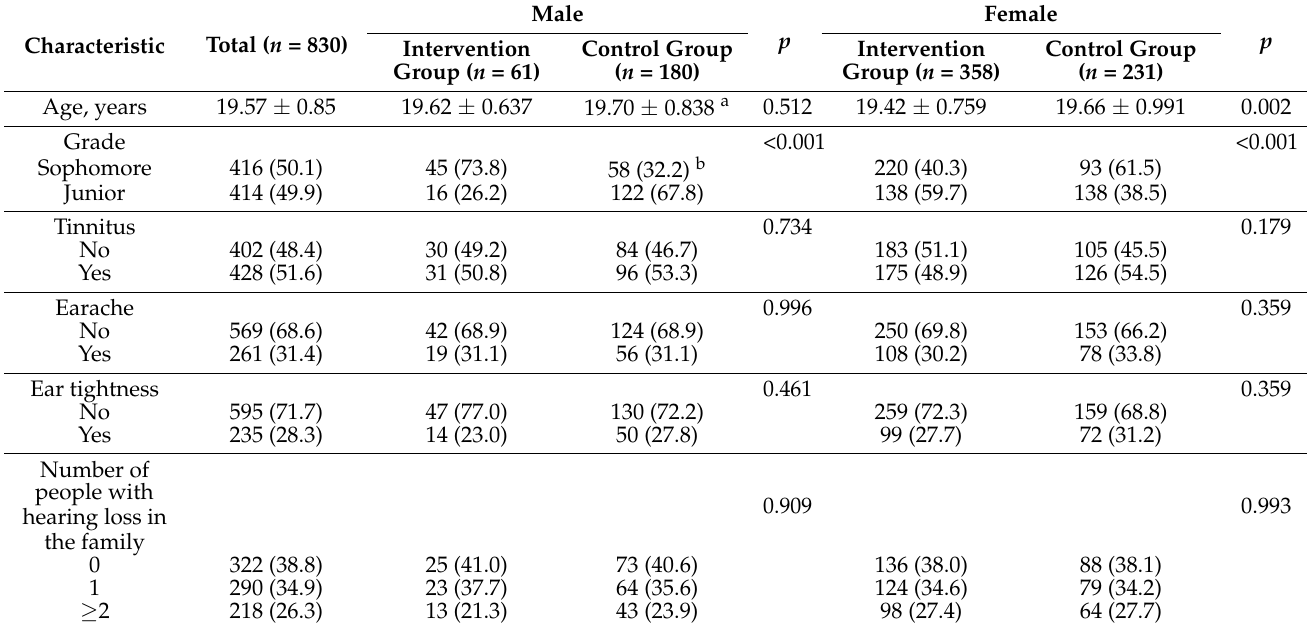
Table 1. College students’ demographic characteristics between intervention group and control group in males and females.